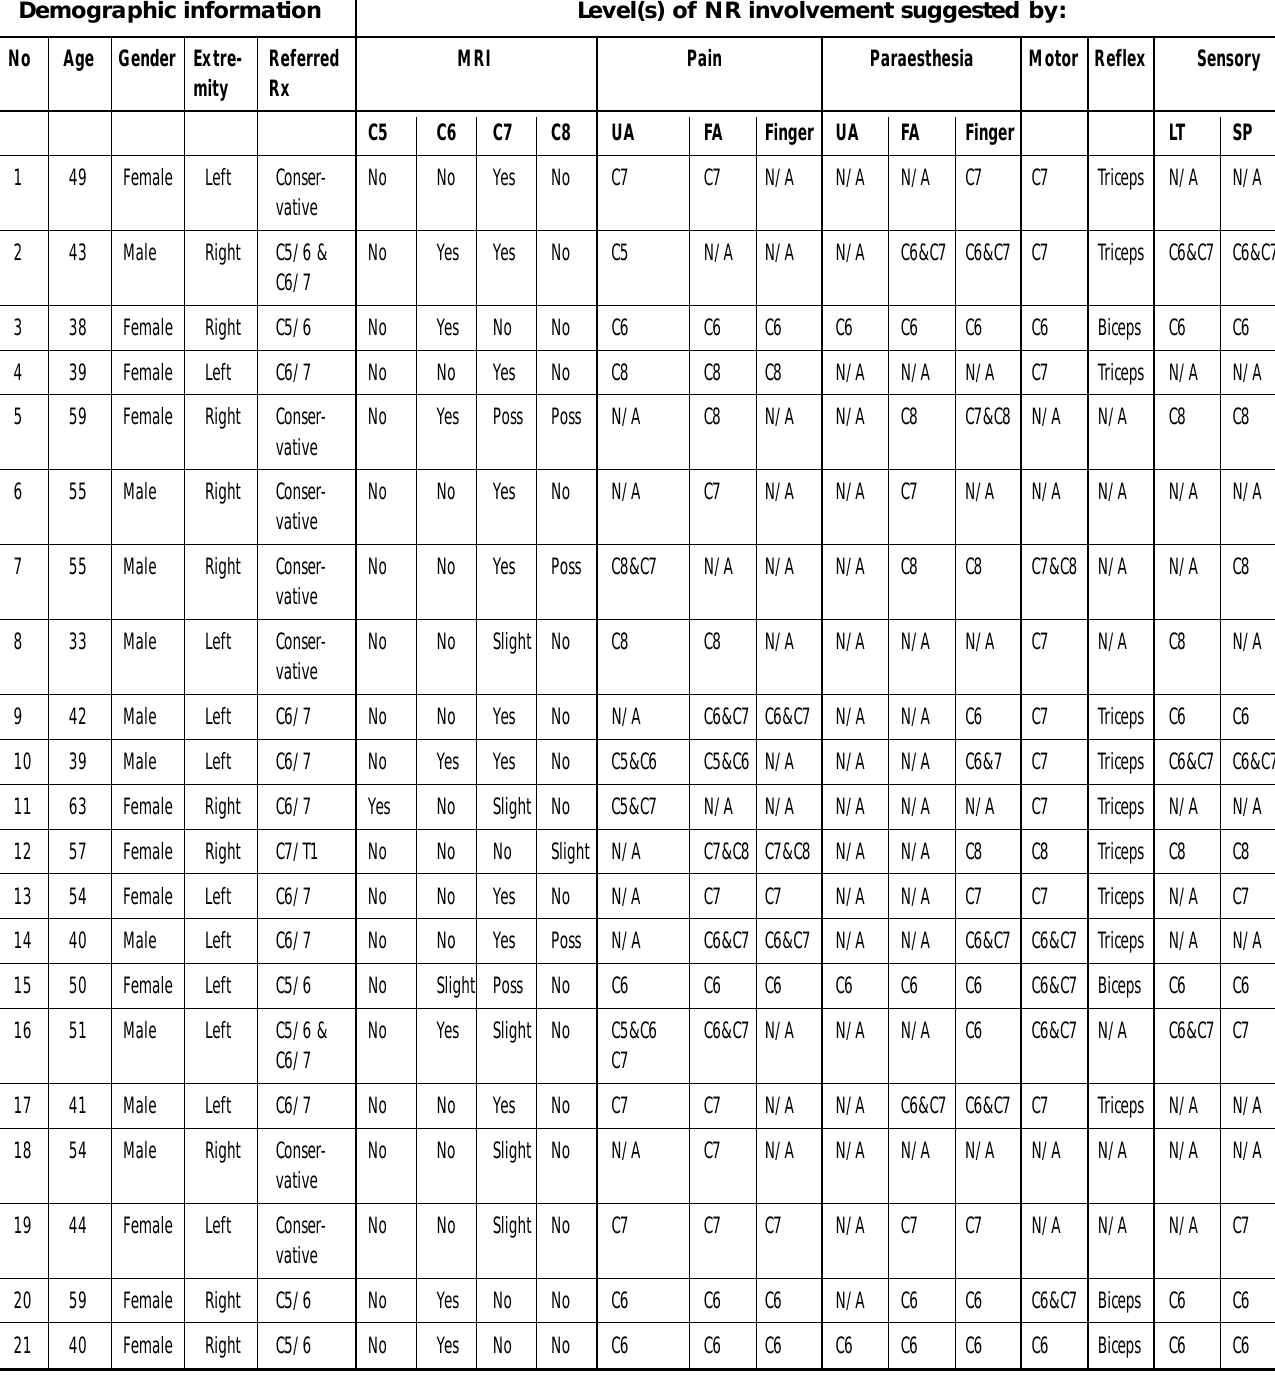
Table 2: Demographic data for the 21 subjects and suggested level(s) of NR involvement for MRI, radicular symptoms and